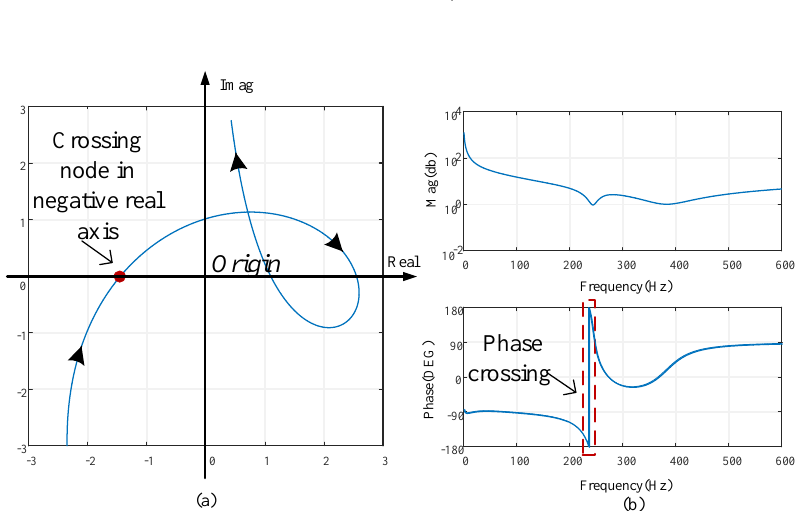
Figure 9. Nyquist and Bode plots of global admittance Y total ( s ) for an unstable grid-connected system. ( a ) Nyquist curve; ( b ) Bode plots. If the minimum R d is negative, the Nyquist plot encircles the origin (0, j 0), reflecting an unstable system. By contrast, if the minimum R d is positive, this means no encirclement around the origin (0, j 0), and the system is stable. The larger the minimum R d value is, the more stable the system. The